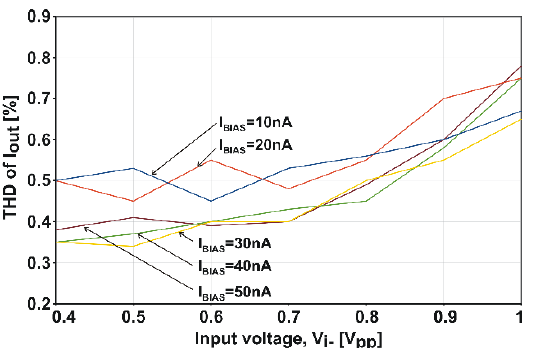
Figure 6. Measured THD (total harmonic distortion) of I out at an asymmetrical input driving. V DD is 1 V and T is 27 °C.